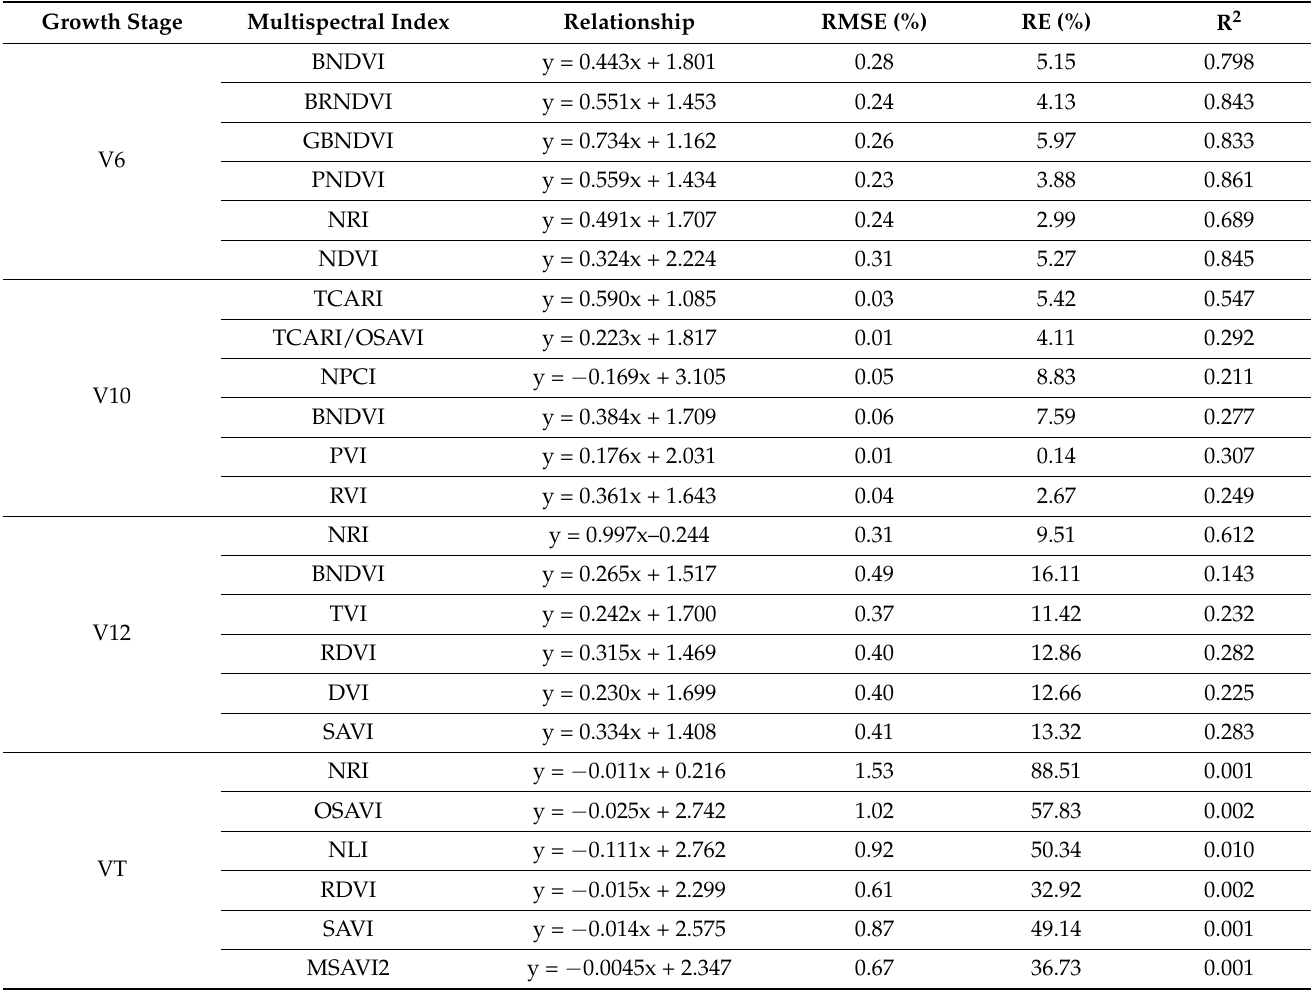
Table 4. Results of UAV multispectral diagnosis and evaluation of nitrogen in summer maize at different growth